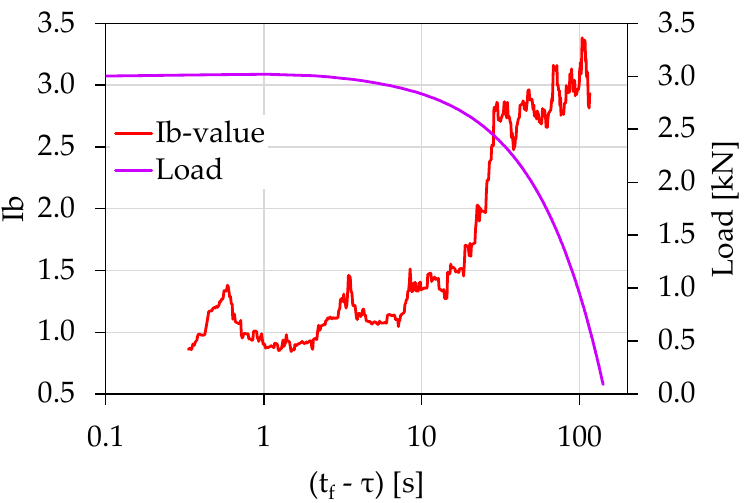
Figure 4. The temporal evolution of the Ib -value in juxtaposition to the load applied for the experiment Exp-LR1 in terms of the “time-to-failure” parameter.